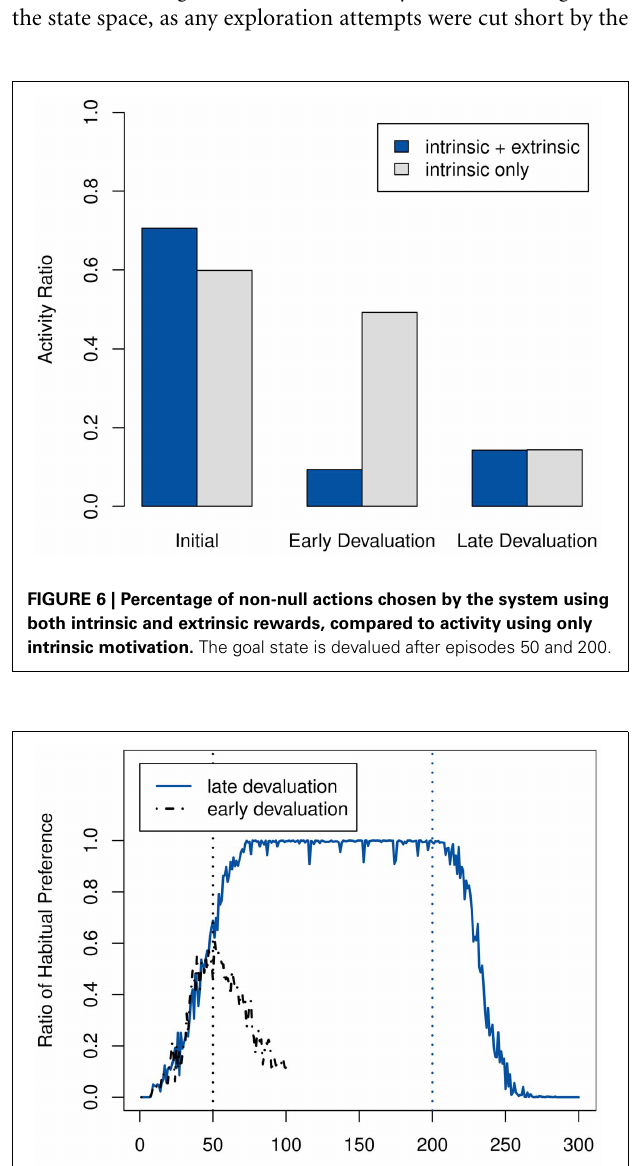
FIGURE 5 | Development of the percentage of non-null action choices, with and without intrinsic rewards. Curves are based on the theoretical greedy choice of action, even in the 20% of cycles in which an (cid:10) -greedy exploratory action was ultimately used. Ratios were determined across bins of 200 samples and smoothed using locally weighted scatterplot smoothing.